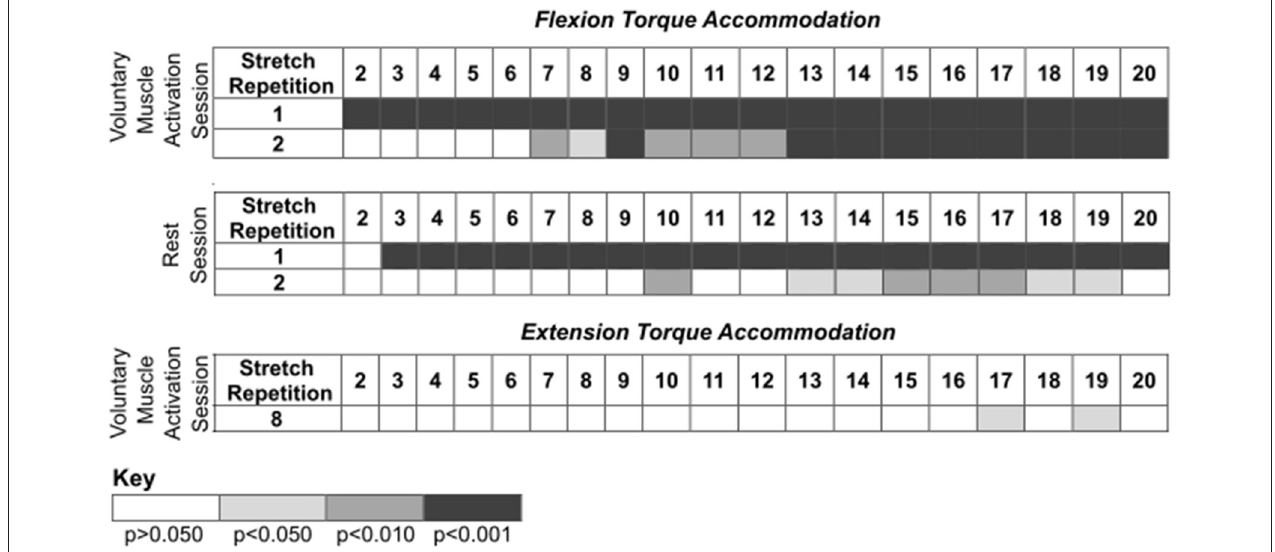
FIGURE 4 | Post-hoc comparisons for the results presented in Figure 3 during the voluntary muscle activation and rest sessions. Rows identify the i th stretch repetition, and columns identify subsequent stretch repetitions. Rows are not included for stretch repetitions that did not have significance. Significance is represented using shading—white: p > 0.050; light gray: p < 0.050; darker gray: p < 0.010; darkest gray: p <